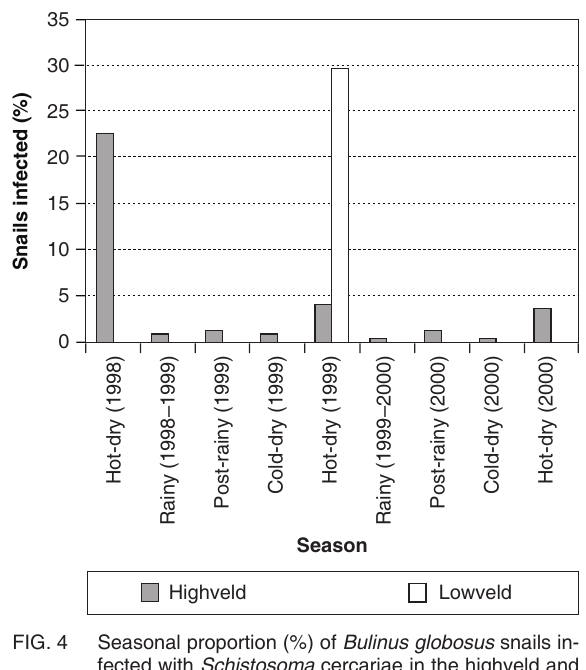
FIG. 4 Seasonal proportion (%) of Bulinus globosus snails in- fected with Schistosoma cercariae in the highveld and lowveld of Zimbabwe for the period November 1998 to October